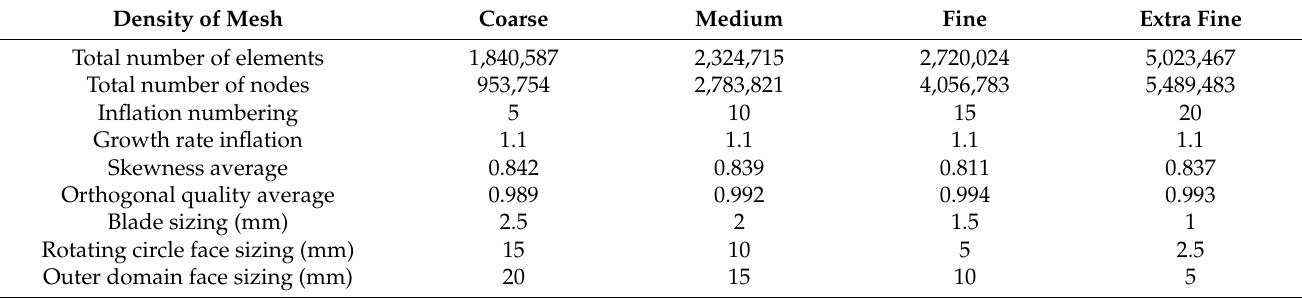
Table 2. Justification of the grid independence